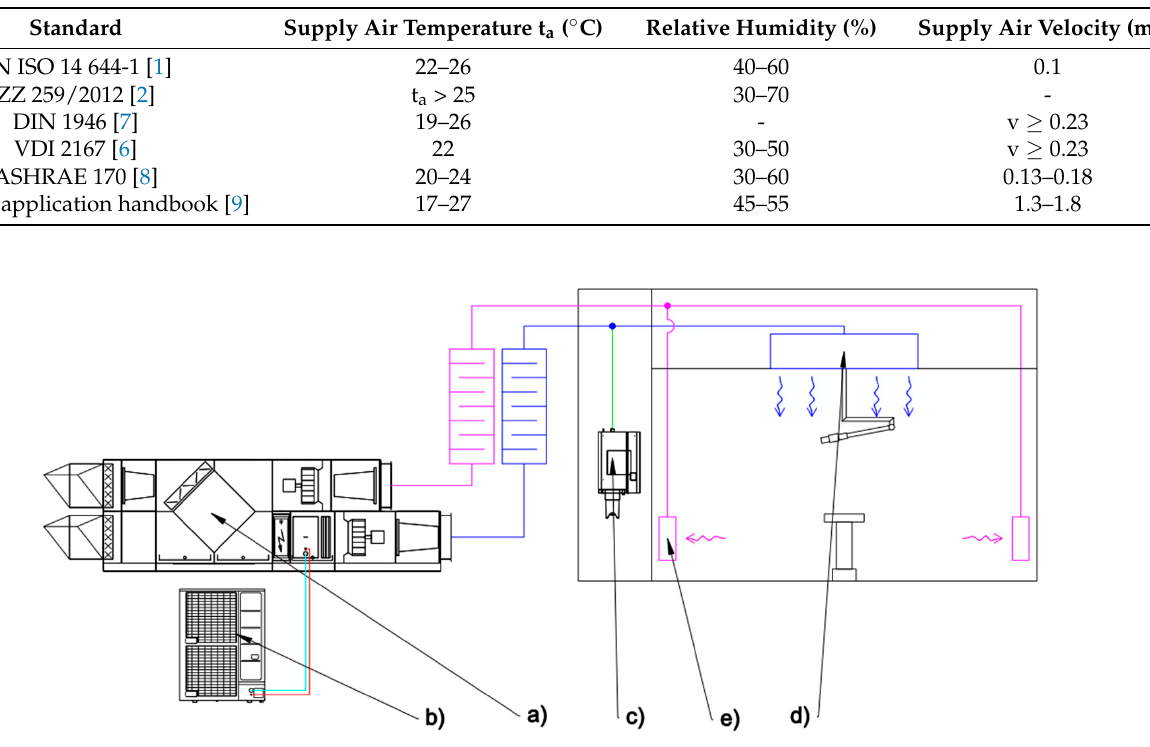
Figure 5. HVAC fl oor plan drawing: (a) ventilation unit, (b) heat pump, (c) air humidi fi er, (d) LAFC, and (e) drainage outlets. The intake square di ff users are also indicated on the HVAC plan drawing. These dif- fusers are designed for clean spaces and were closed with tight check valves during the measurement. This will avoid a ff ecting the air fl ow through the LAFC, and only the air- fl ow image formed by the fl ow through the LAFC will be monitored. In a previous study [20], a di ff erence in the air fl ow rate gradients in the entire cross-section of the OR was visible, due to the change in the air fl ow rate through the LAFC. A comparison of the pro fi les passing through the center of the LAFC for the out fl ow velocity of 0.15 and 0.25 m/s through the LAFC is shown in Figure 6.